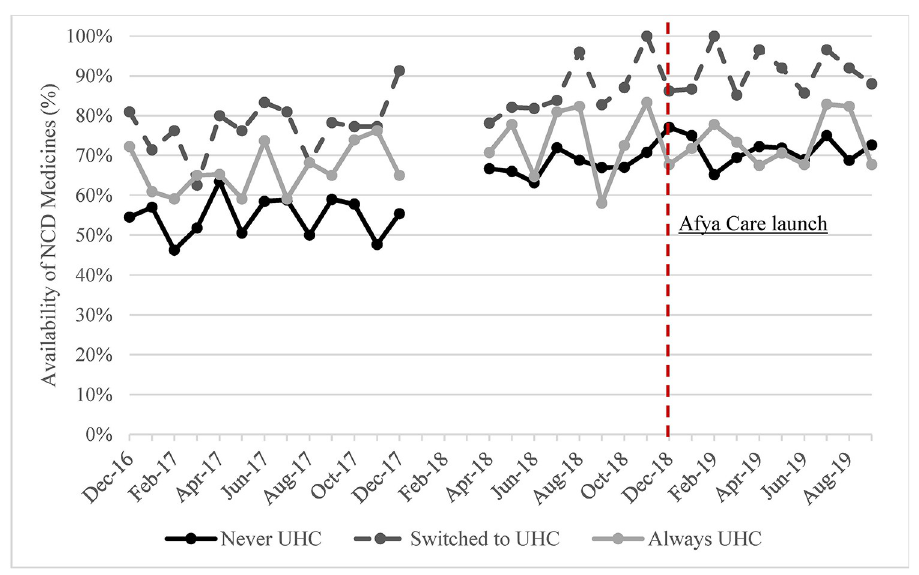
Fig 3. Availability of NCD medicines by UHC.